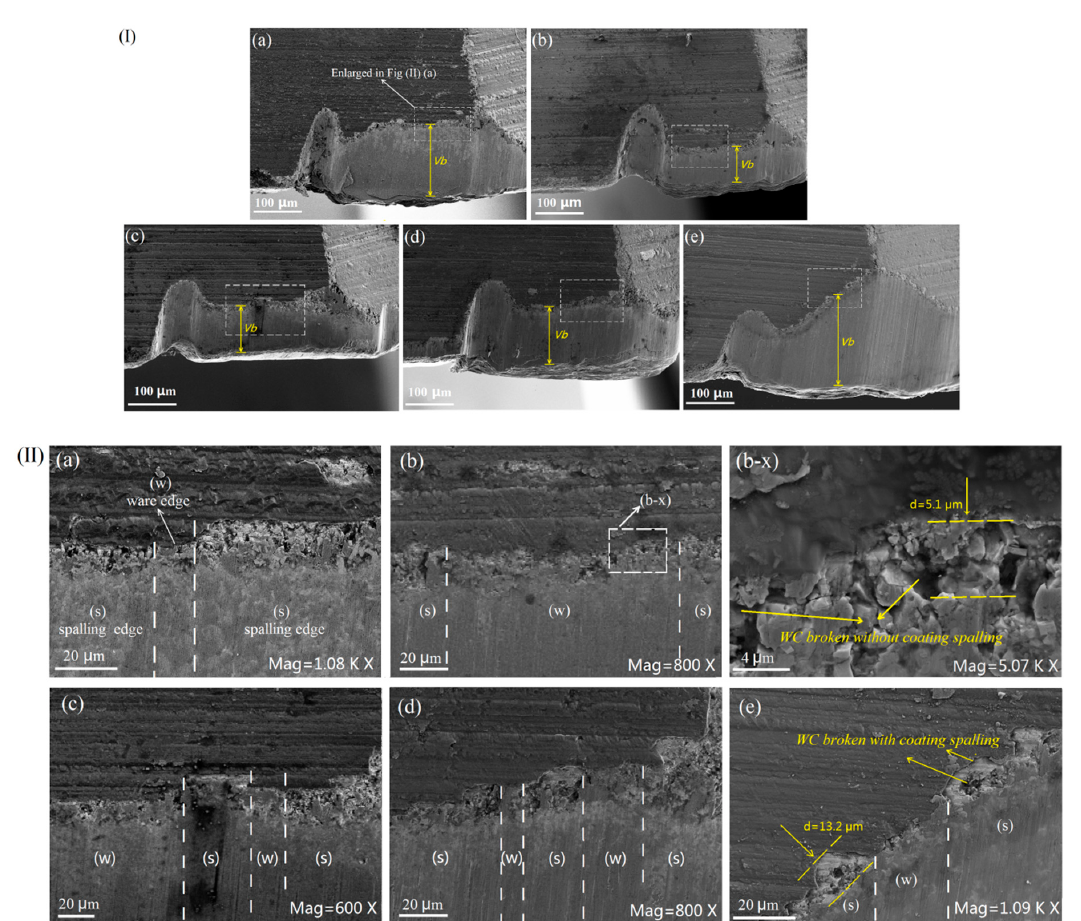
Figure 11. ( a )Tool flank wear Vb curve versus cutting length of different coated tools. ( b ) Tool flank wear Vb and length ratio k curve versus Ti layers thickness of different coated tools, k = W/S = ∑ ( w )/ ∑ ( s ).